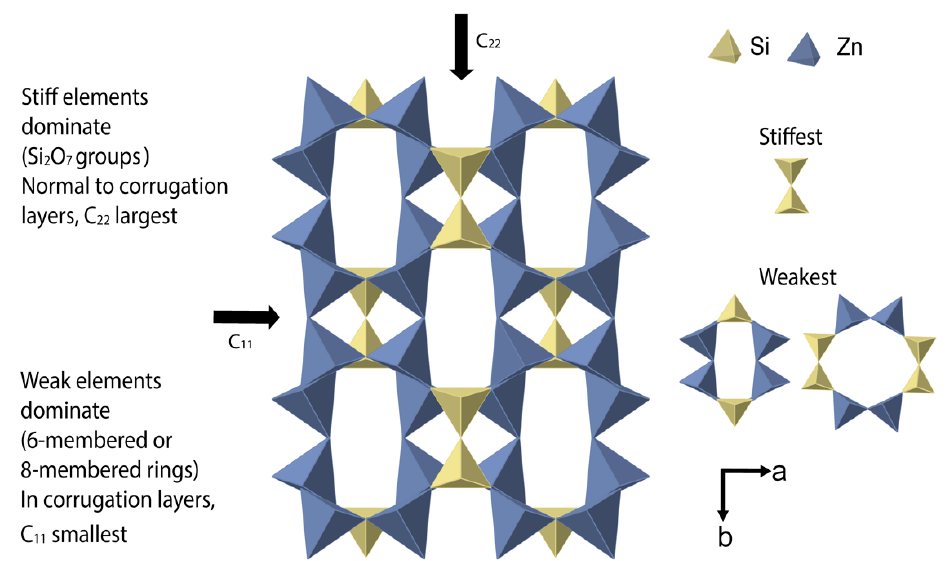
Figure 3. Schematic illustration of a polyhedral model of mineral elasticity. Hydrogens in molecular water and hydroxyls are omitted to emphasize linkages among Si and Zn tetrahedra into corrugated sheets of 3-membered rings parallel to (010), and the bridging between sheets. Sti ff ness parallel to [010], normal to the sheets, depends on the strongest structural element in this direction, which are Si 2 O 7 and Zn 2 O 6 (OH) 2 groups that bridge the sheets along b. Within the plane of the sheets, the moduli depend on the weakest structural elements [19]. C 11, measuring sti ff ness in the a direction, depends, in part, on the sti ff ness of relatively weak 6-membered and 8-membered rings, which can accommodate strain along [100].